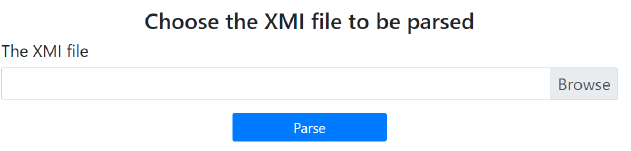
Figure 10. The input screen of the parser.